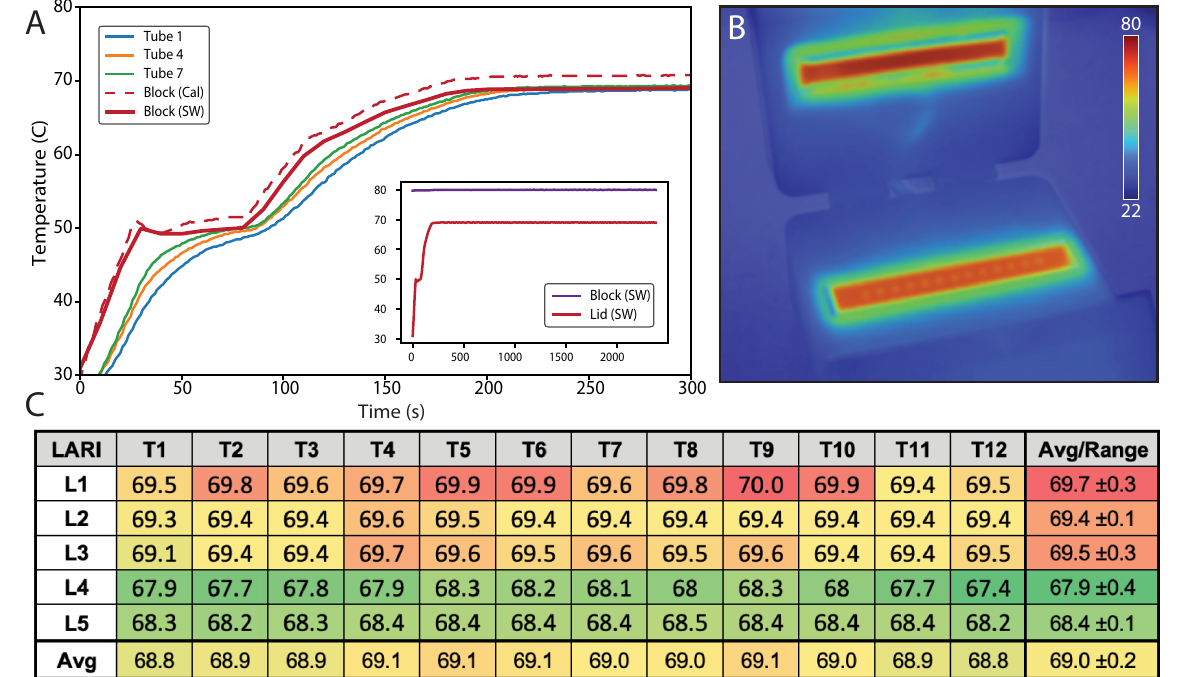
Fig 4. Thermal performance of LARI. (A) Transient temperature response over two temperature set points as measured at three different tube locations: T1 (leftmost tube), T4 (directly over left cartridge heater), and T7 (center of block). Also shown are the software-reported temperature readings as well as temperature monitored with the calibration RTD within the block. Tube temperature lags block temperature by about 10–20 s, with outermost tube lagging the worst. Inset shows full 40-minute run. (B) Steady-state thermal camera image of LARI with tube block at 69˚ C and lid block at 80˚ C. (C) Steady-state sample tube temperature across 5 LARIs as measured with an external thermocouple inserted in water in each tube, showing excellent temperature